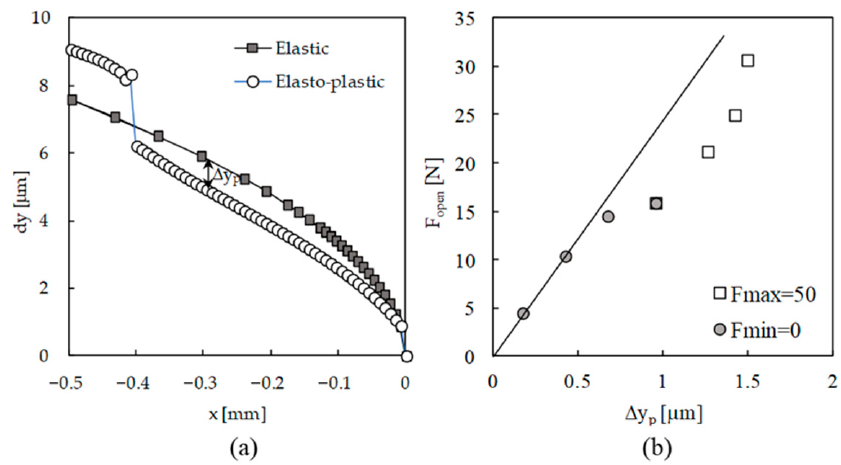
Figure 6. ( a ) Elongation of residual plastic wedge, ∆ y p , measured at maximum load ( F max = 50 N; F min = 0). ( b ) Crack opening level versus ∆ y p .